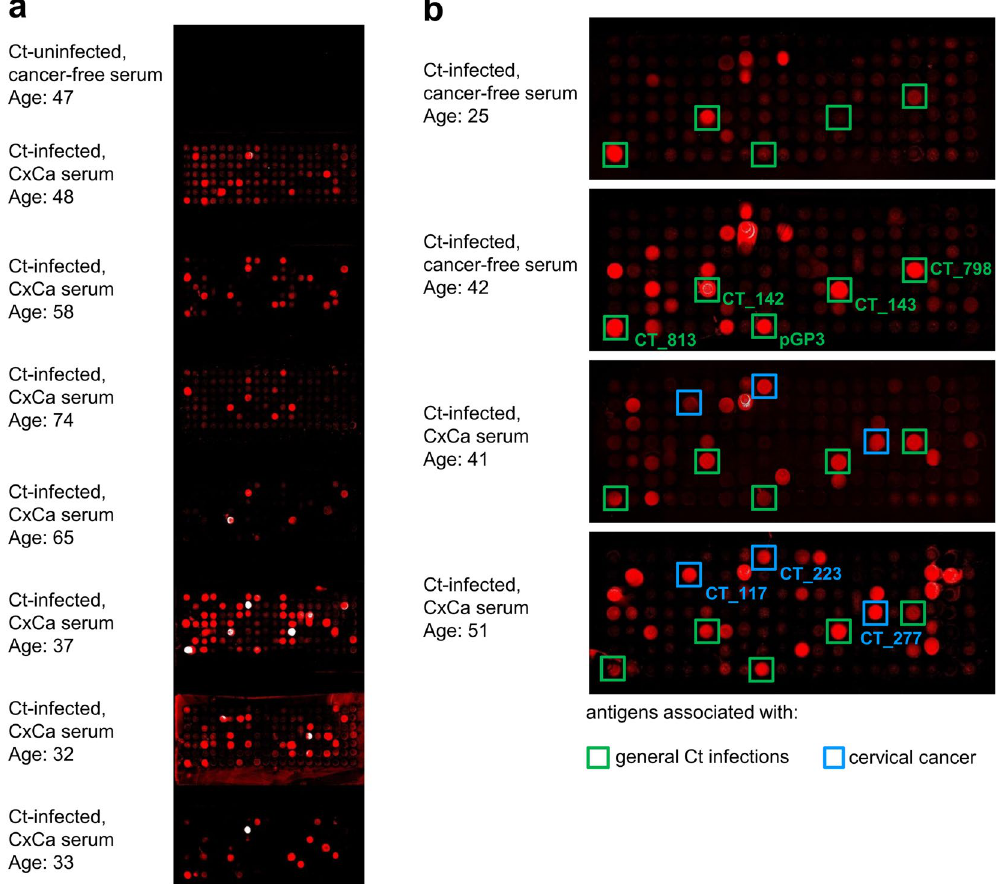
Figure 5. Antibody patterns in individual sera with 130 selected Ct antigens. ( a ) Each microarray comprised 8 blocks and each block contained the same 130 Ct antigens and 10 negative controls (NC1). Individual blocks were incubated with serum from a Ct-uninfected woman (topmost block), and seven Ct-infected cervical cancer patients. ( b ) Enlarged view of antibody reactivity patterns in single sera from Ct-infected women, the top two being cancer-free and the bottom two with cervical cancer. Boxed spots highlight potential markers for general Ct infection (green) and cervical cancer